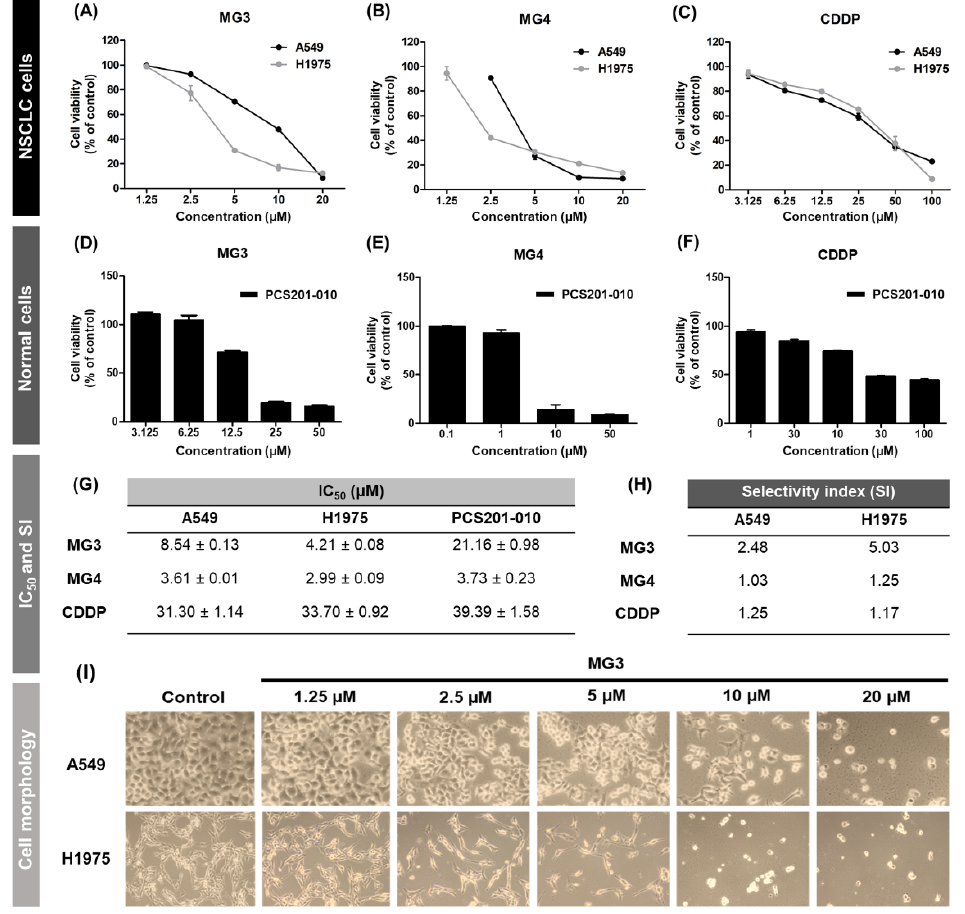
Figure 2. Cell viability of NSCLC ( A–C ) and PCS201-010 ( D–F ) cell lines after treatment with MG3, MG4, and CDDP for 48 h. The IC 50 ( µ M) and SI of three focused compounds against all studied cell lines are shown in ( G ) and ( H ), respectively. ( I ) The morphological changes of two NSCLC cell lines treated with MG3 at various concentrations for 48